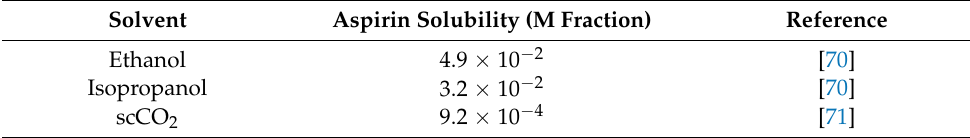
Table 7. Aspirin solubility in ethanol and isopropanol at 18 ◦ C and in scCO 2 at {80 ◦ C; 30 MPa}.